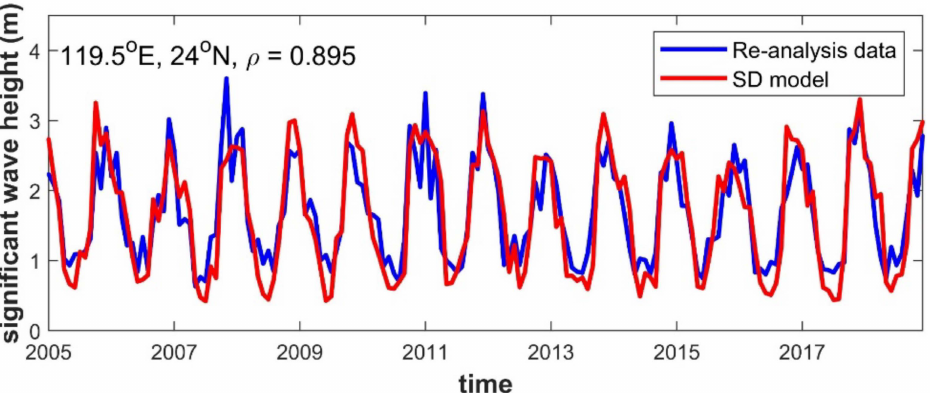
Figure 11. Comparison of monthly between the quasi-real data and the model at 24 ◦ N, 119.5 ◦ E in a time series for the validation period from 2005 to 2017. The blue line shows the monthly from the re-analysis data. The red line is the monthly from the proposed downscaling approach. The correlation coefficient is approximately